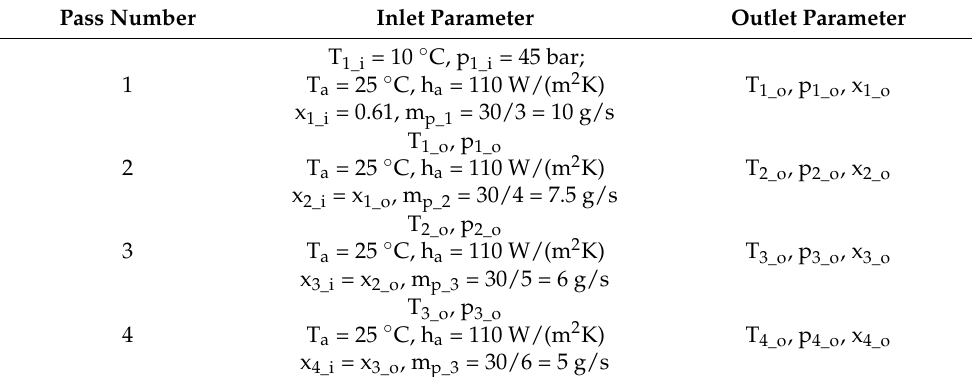
Table 2. Inlet parameters and measured